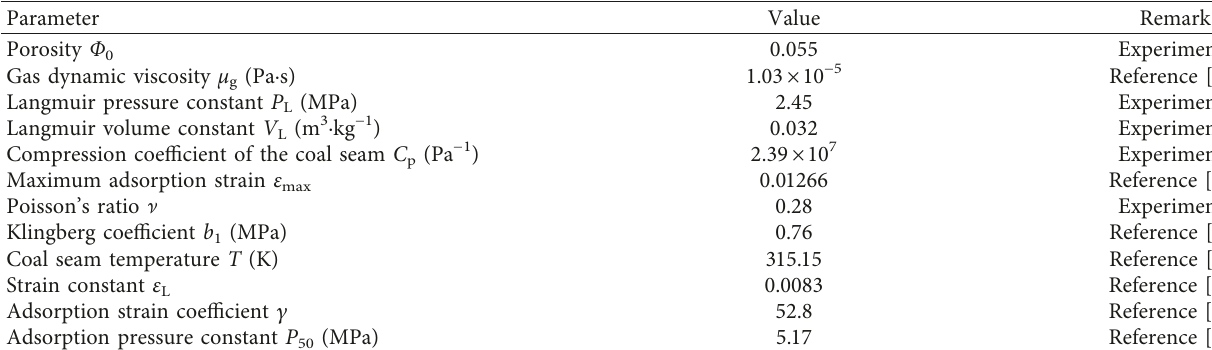
Table 2: Parameters of gas extraction in the coal seam.